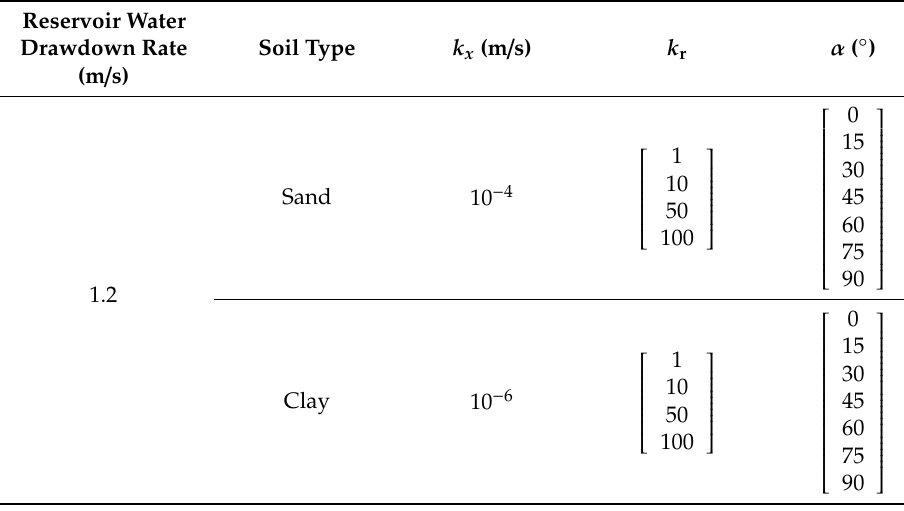
Table 3. Di ff erent calculation